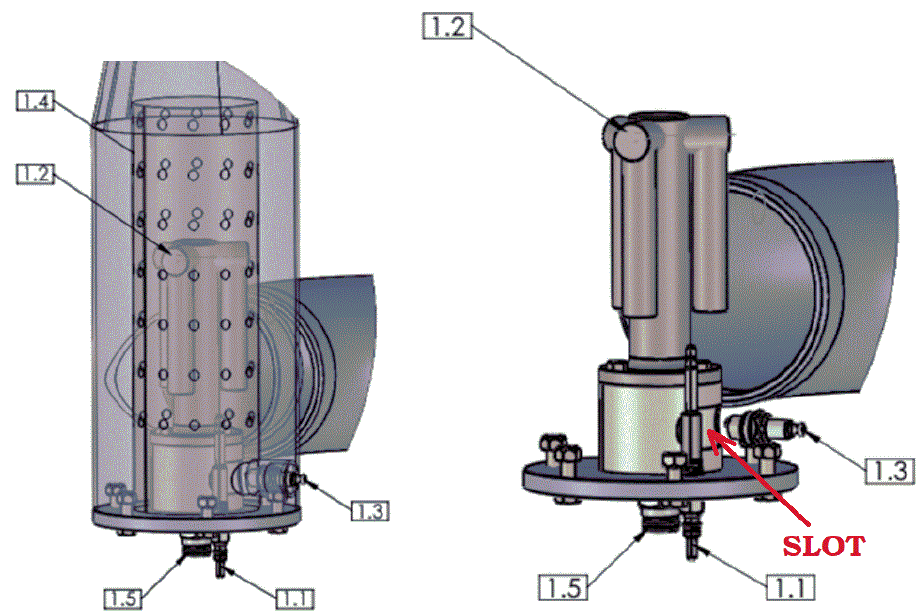
Figure 4. Layout of the combustor. Transparent view on the right and inner view on the left. 1.1. Restart glow plug. 1.2. Vaporization piping system. 1.3. Heated injector for starting. 1.4. Mixing holed pipe. 1.5. Fuel spray nozzle.